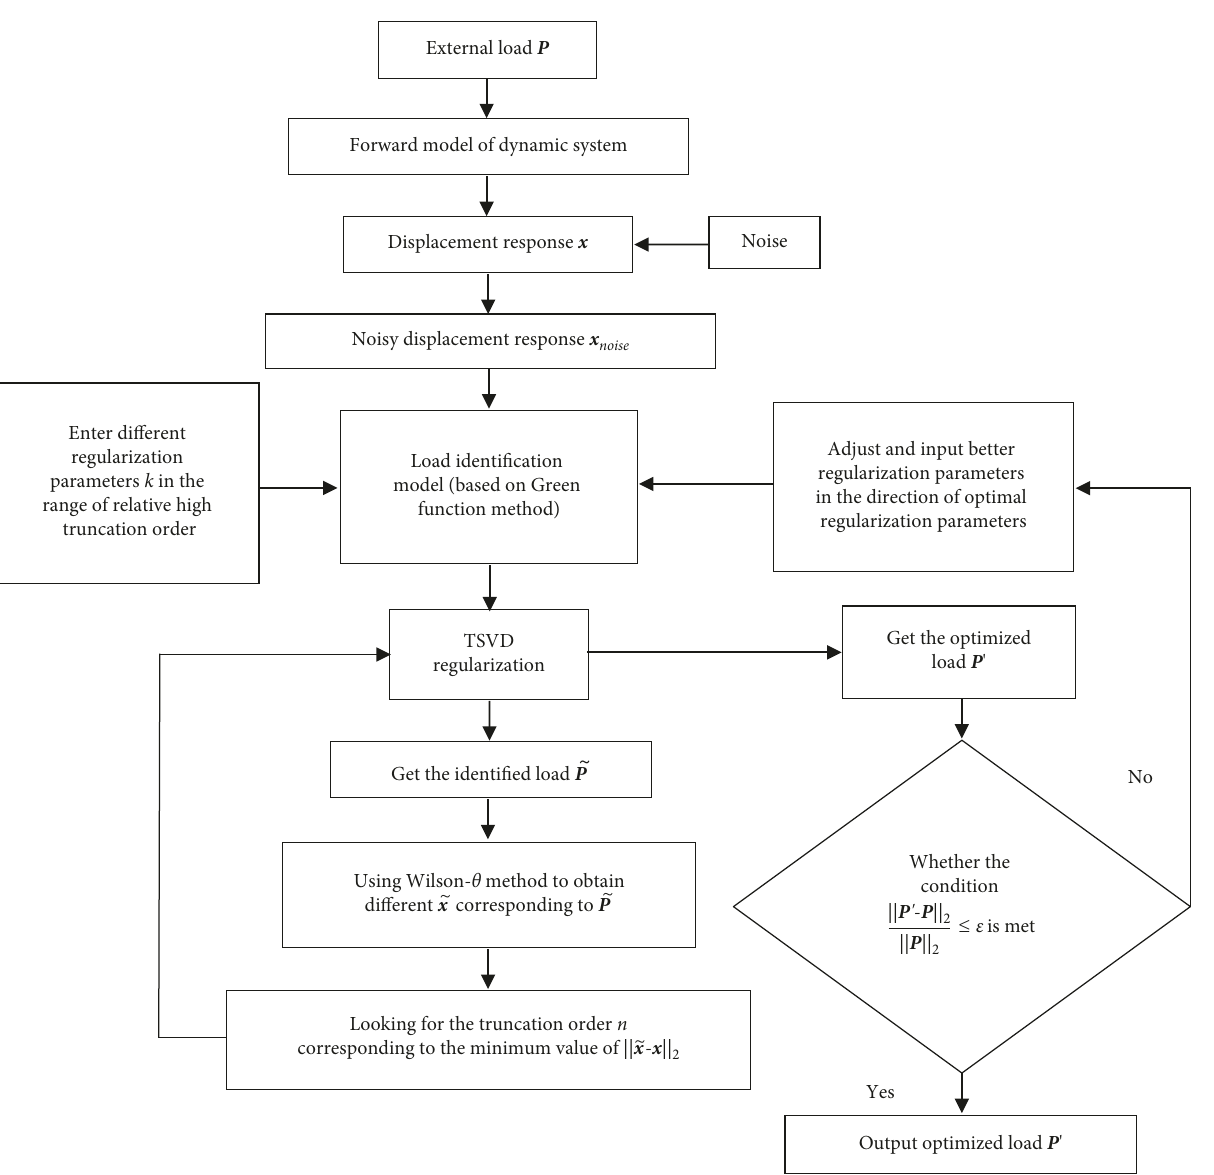
Figure 1: Flowchart of the parameter-selection method for TSVD regularization based on Wilson-